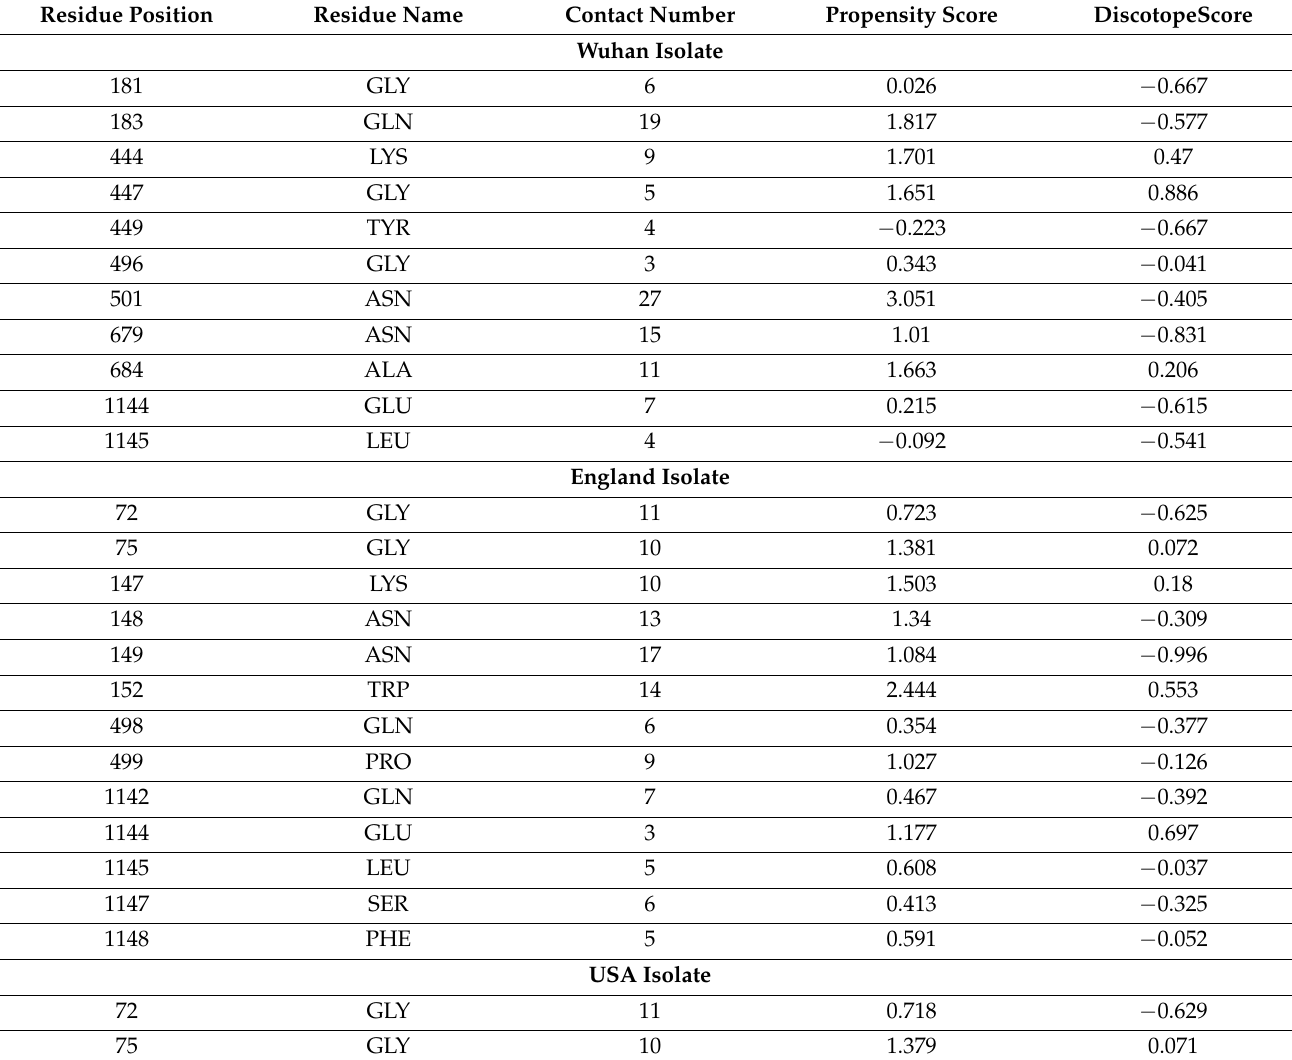
Table 5. Discontinuous B-cell epitopes of SARS-CoV variants predicted by